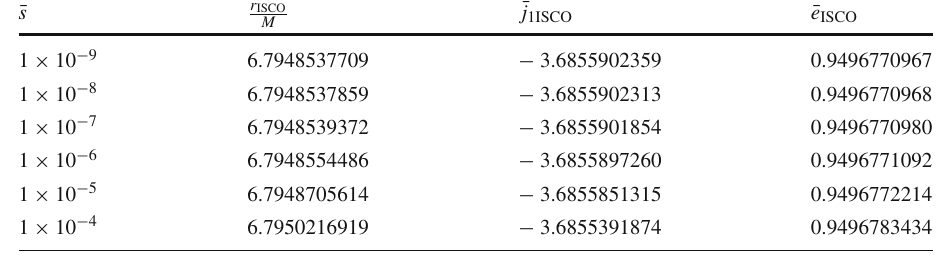
(counter-rotating orbit) parameters of the spinning test particle in the black hole background with a = 0 . 25 and